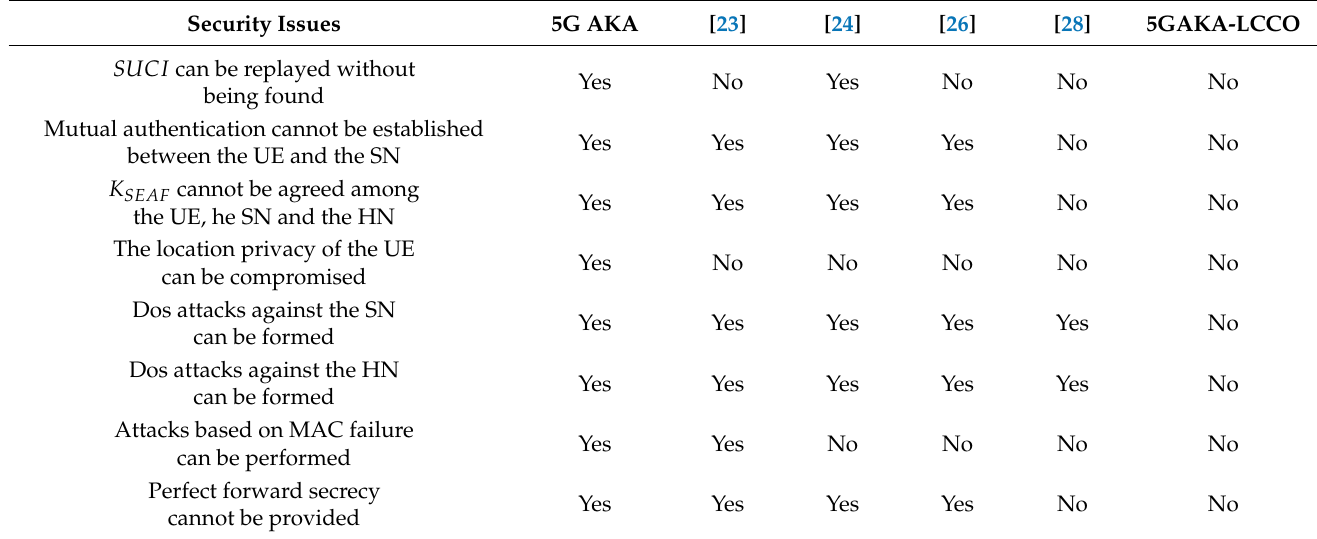
Table 1. Comparative analysis between the 5GAKA-LCCO protocol and the recently improved 5G AKA protocols [23,24,26,28] regarding the shortcomings of the latest version of the 5G AKA